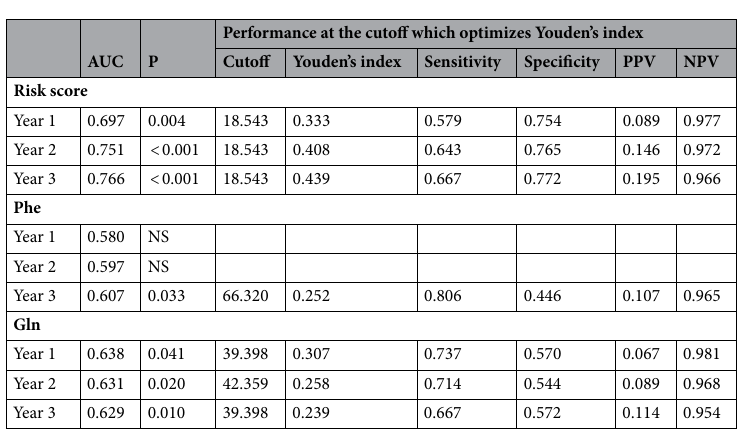
Table 3. The classification of HCC status at the subsequent years 1, 2 and 3 after patient recruitment.